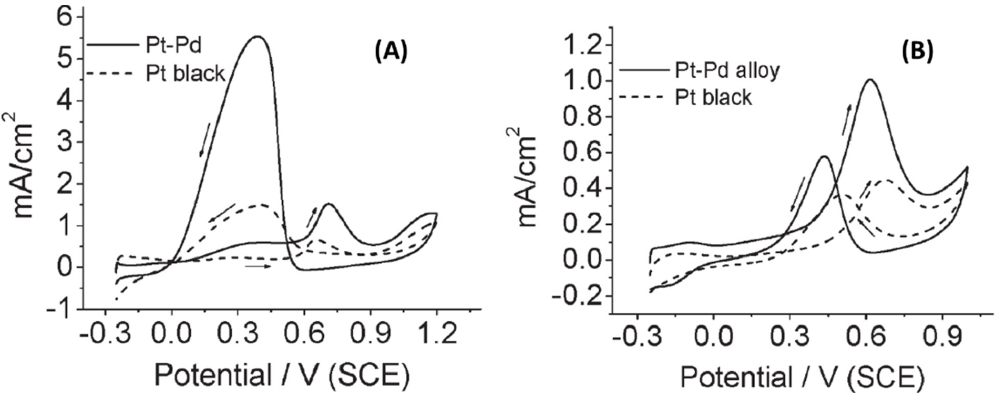
Figure 15. Cyclic voltammograms for electro-oxidation of ( A ) formic acid and ( B ) methanol using as-prepared Pd-Pt hypercubes, Pt black is shown using dashed lines in both cases. Adapted with permission from the American Chemical Society. Copyright 2014 American Chemical Society.